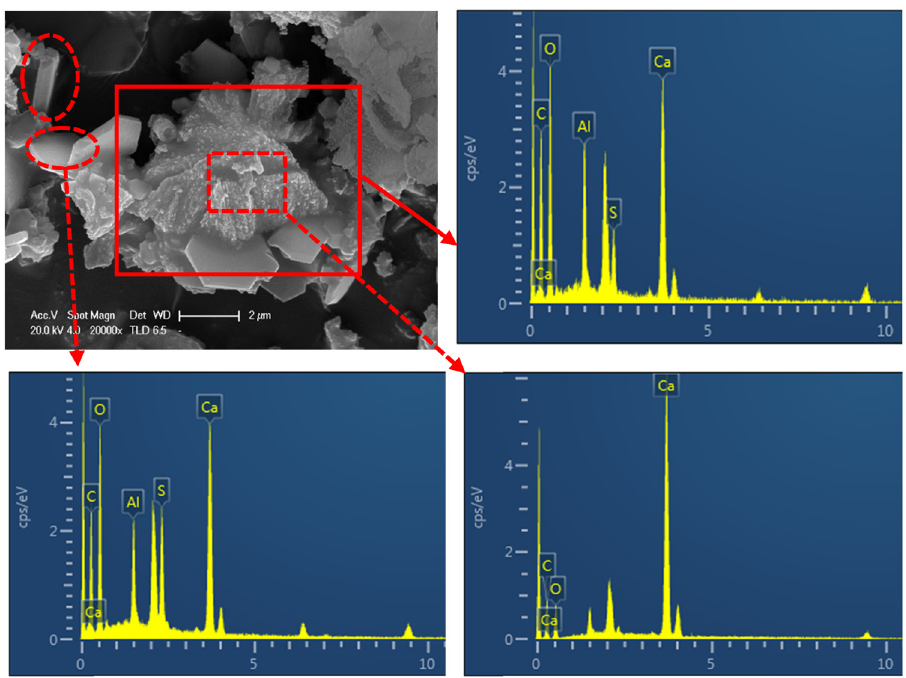
Figure 7: EDS spectrogram of the products in the crack